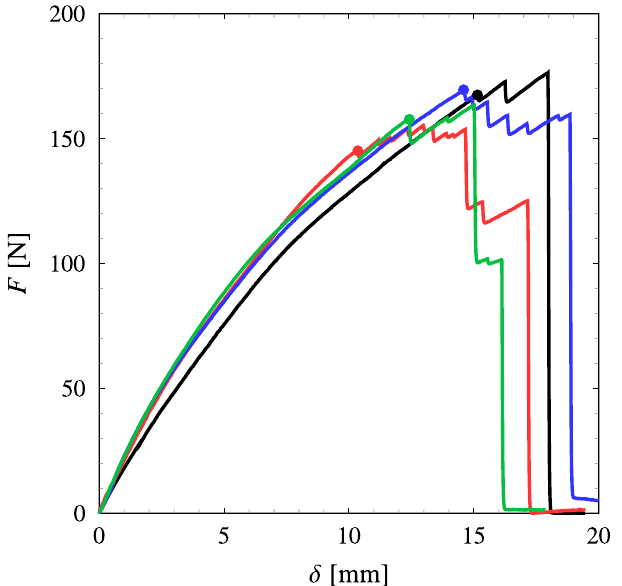
Figure 6. The load-displacement curves of four cracked pure-shear specimens where the solid circles denote the crack initiation points.